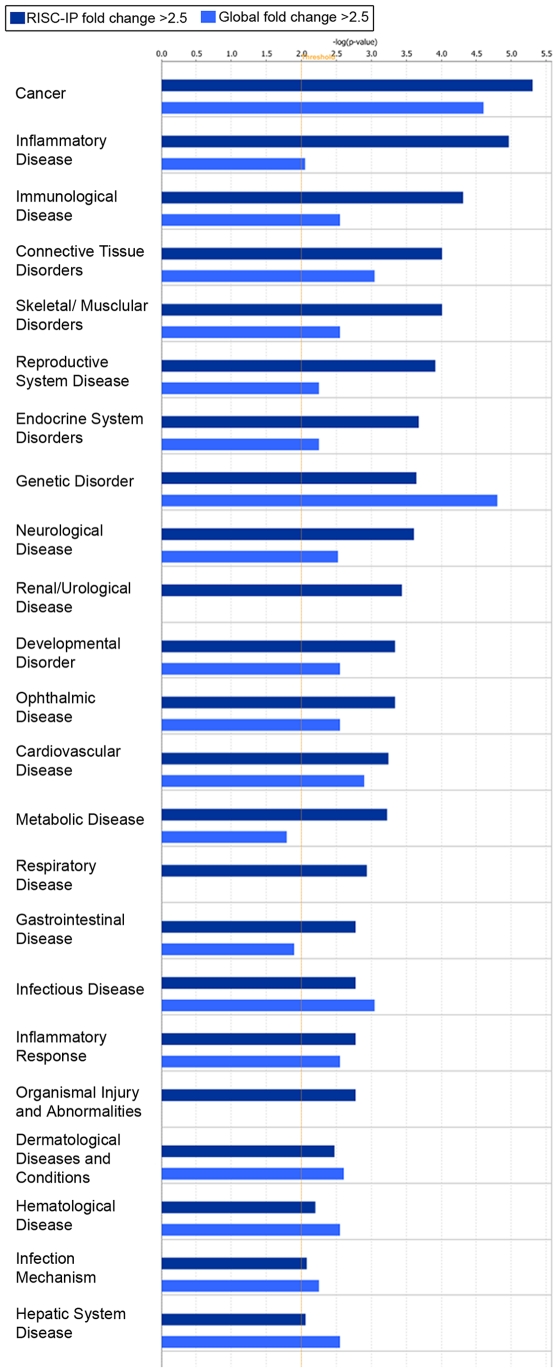
Disease and disorder representation of the mRNA in the RISC of U-87 astrocytoma cells compared to primary astrocytes and the mRNA in the global cellular milieu of U-87 astrocytoma cells compared to primary astrocytes.Bar charts display the relative number (-log(p-value)) of mRNAs with a fold change >2.5 and were considered significant (p<0.01). RISC-IP mRNA were indicated with dark blue bars and the global mRNA were indicated with light blue bars. The threshold (yellow lines) were set at p<0.01 and were calculated using Fischer's exact p-value test using IPA software.